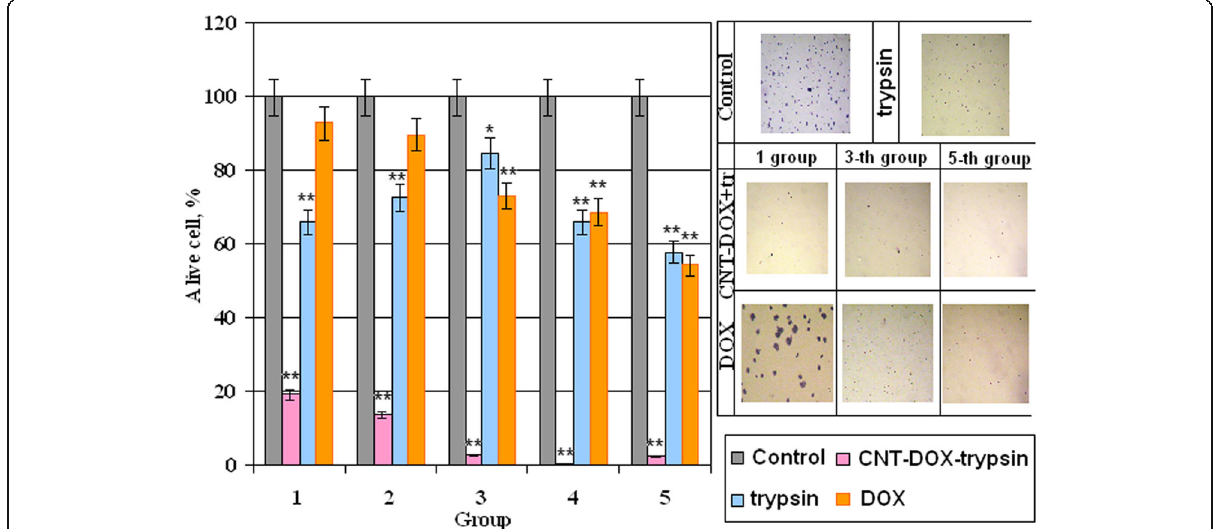
Fig. 8 Percentage of alive cells HT29 after 48 h of incubation in the presence of trypsin, doxorubicin, CNT-Dox. Statistical significance: * р ≤ 0.05 or ** р ≤